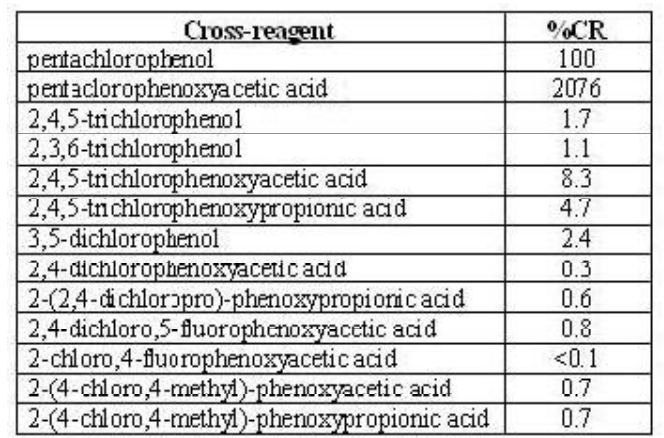
Cross-Reactivity Percentages (%CR) for Related